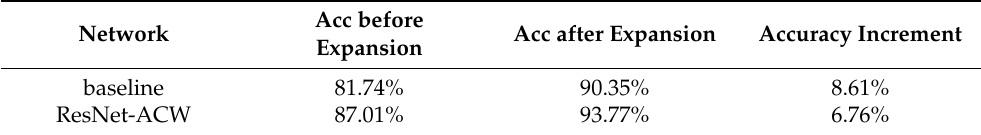
Table 10. Change in network accuracy after expansion of synthetic data.